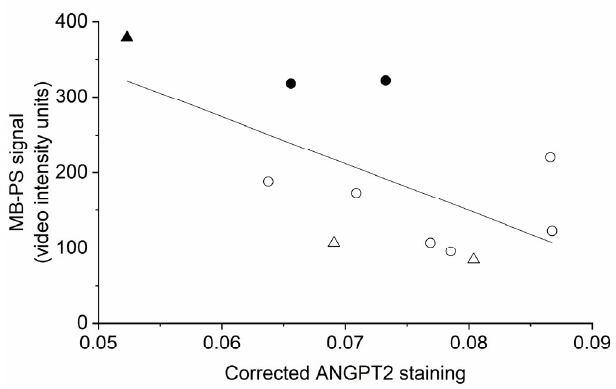
Figure 5. Phosphatidylserine ‐ shelled microbubble (MB ‐ PS) signal and angiopoietin 2 (ANGPT2) display a significant and negative linear relationship ( R 2 = 0.31, p = 0.045). Circles indicate treatment with a chow, control diet, and triangles a western ‐ style diet. Filled symbols represent treatment with testosterone.